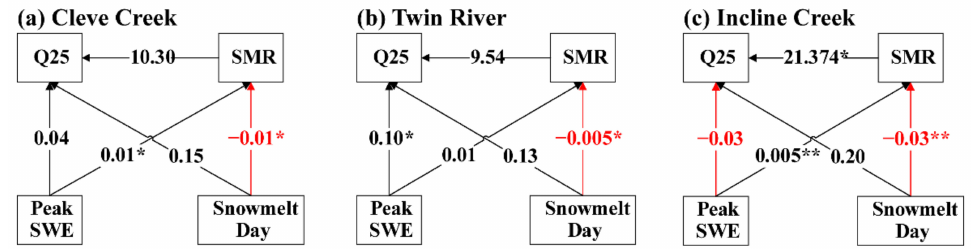
Figure 5. Structural equation model examining the multivariate effects on Q25. The black and red arrows represent positive and negative effects, respectively. The asterisk symbols * and ** indicate that effects are significant at the 0.01 and 0.05 levels,